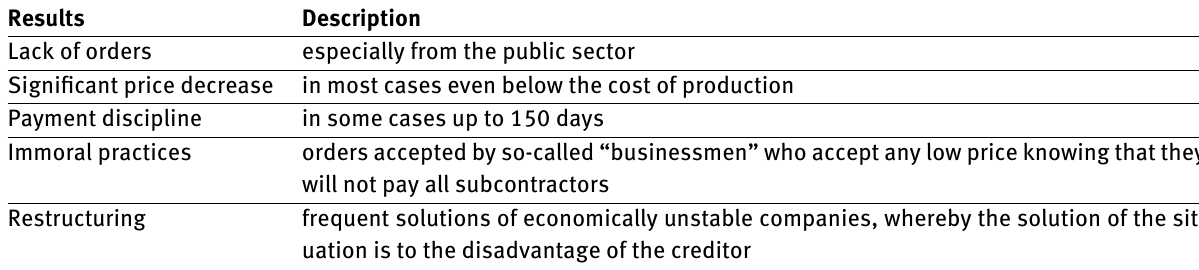
Table 2: Results of the analysis of the construction industry.